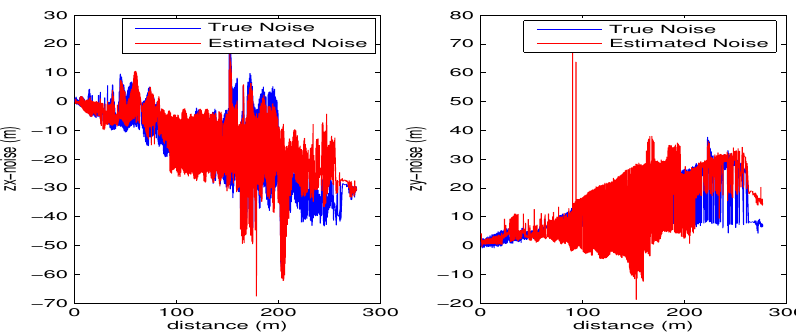
Figure 9. The estimated measurement error data according to method 2.